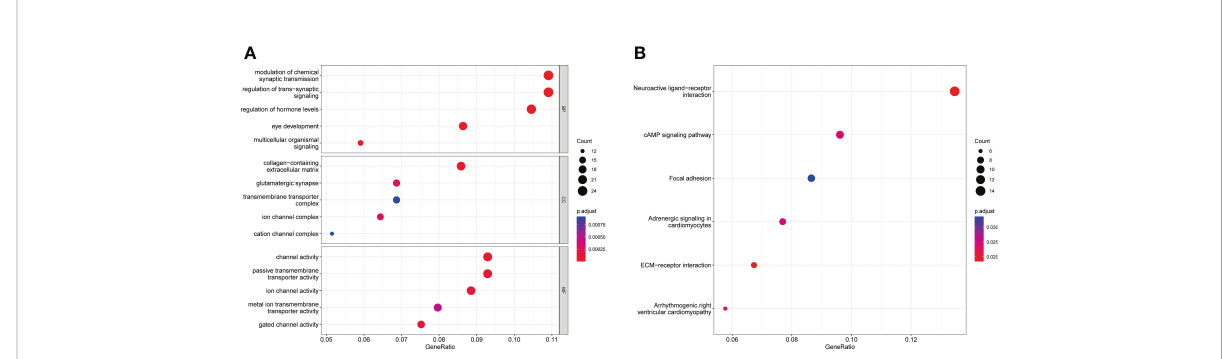
FIGURE 3 DEG enrichment results. (A) Bubble chart for GO analysis showing the top fi ve GO terms for biological process (BP), cellular component (CC) and molecular function (MF). (B) Bubble chart for KEGG pathway analysis showing the top six enriched KEGG pathways in